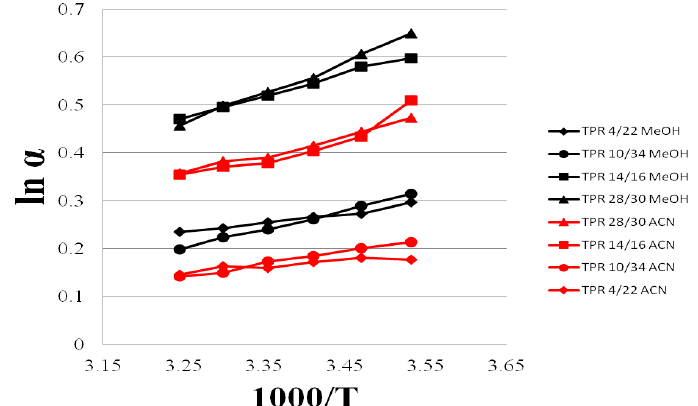
Figure 7. The phase ratio-independent selectivity curves for analytes differing with the heteroatoms at R1 substituents (TPR 14/16 and 28/30) and the methylene group (TPR 4/22 and TPR 10/34) obtained on Chirobiotic column. Experimental conditions: teicoplanin column (CHIROBIOTIC TM ), 15% ACN (red lines) and 15% MeOH (black lines) mobile phases, at a flow rate of 1 mL/min.